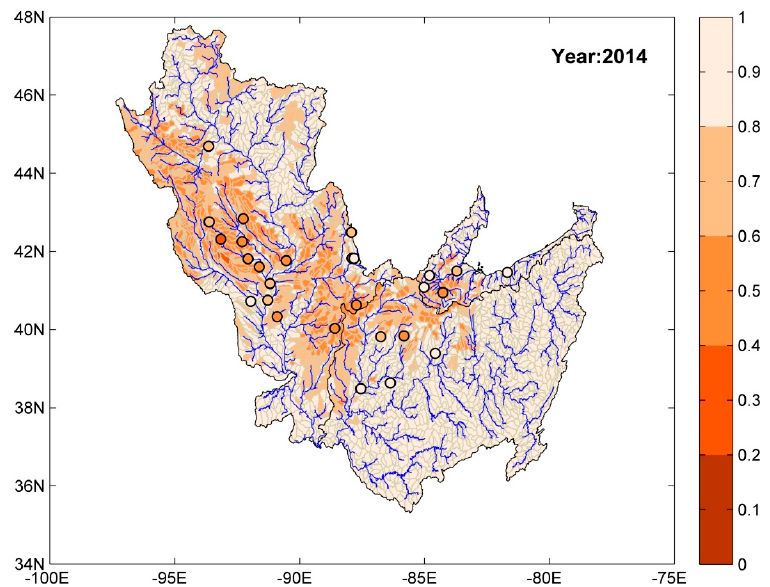
Figure 8. Prediction of watershed health (with respect to nitrite + nitrate) at ungauged HUC-10 basins for the year 2014 using the ensemble model. Circular markers denote the location of USGS- NAWQA stations where nitrite + nitrate measurements were available and are color-coded based on the watershed health for the year 2014. Watershed Health for Orthophosphate